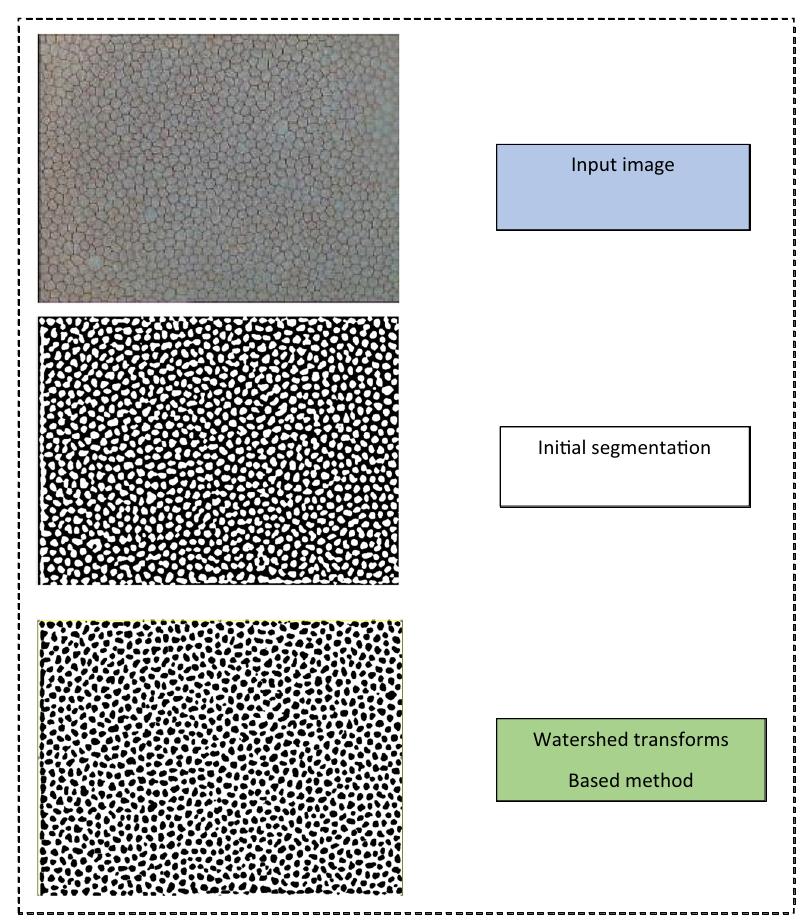
Figure 14: Images depicting the output of the TWDS segmentation - based